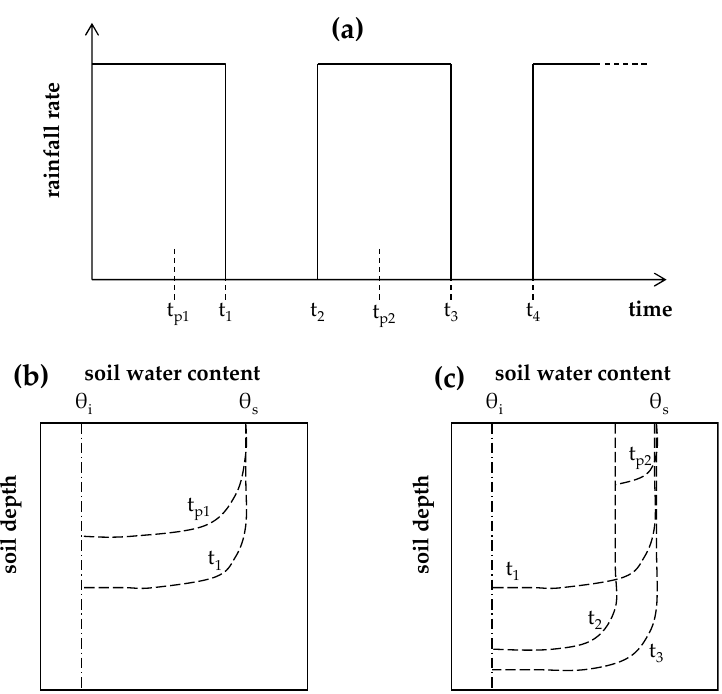
Figure 4. ( a ) Rainfall pattern selected to describe the Corradini–Melone–Smith semi-analytical model for point infiltration. ( b , c ) Profiles of soil water content at various times indicated in ( a ) and associated with different infiltration-redistribution stages. For symbols, see the text.